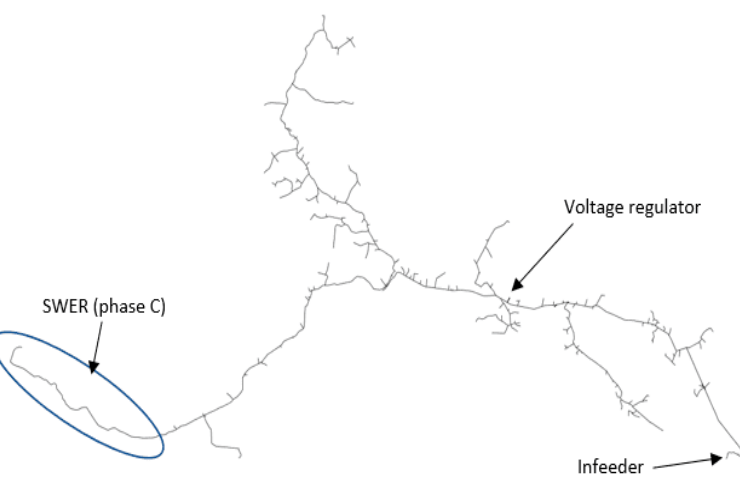
Figure 4. Real distribution feeder network model supplied at 22 kV. The infeeder, voltage regulator and SWER line are shown.